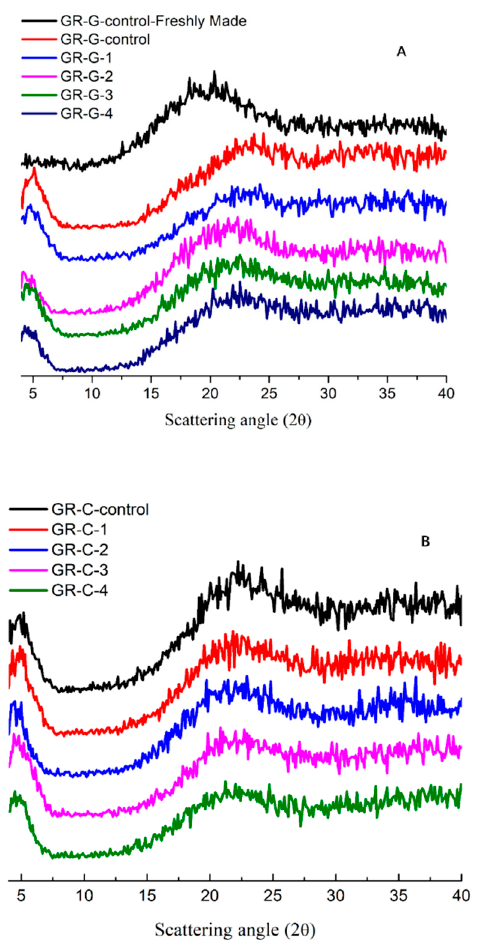
Figure 5. Separated X-ray diffractograms of glutinous rice gel sample ( A ) and sweetened glutinous rice cake samples ( B ). GR-G-control, GR-G-1, GR-G-2, GR-G-3, GR-G-4 represented that rice gel samples after 14 days of storage at 4 ◦ C, made of 0, 100, 200, 300, 400 pulses of 3 kV/cm PEF treated rice grains, respectively; GR-C-control, GR-C-1, GR-C-2, GR-C-3 and GR-C-4 represented that rice cake samples after 14 days of storage at 4 ◦ C, made of 0, 100, 200, 300, 400 pulses of 3 kV/cm PEF